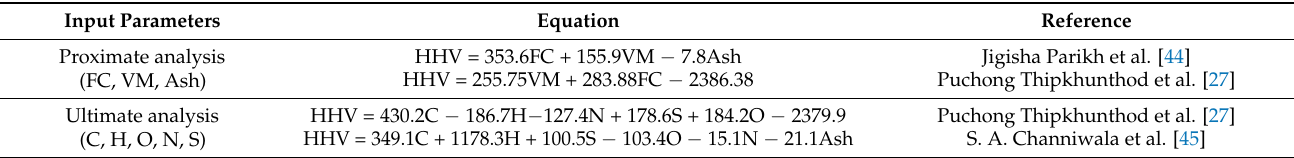
Table 4. Various HHV prediction models from the literature.